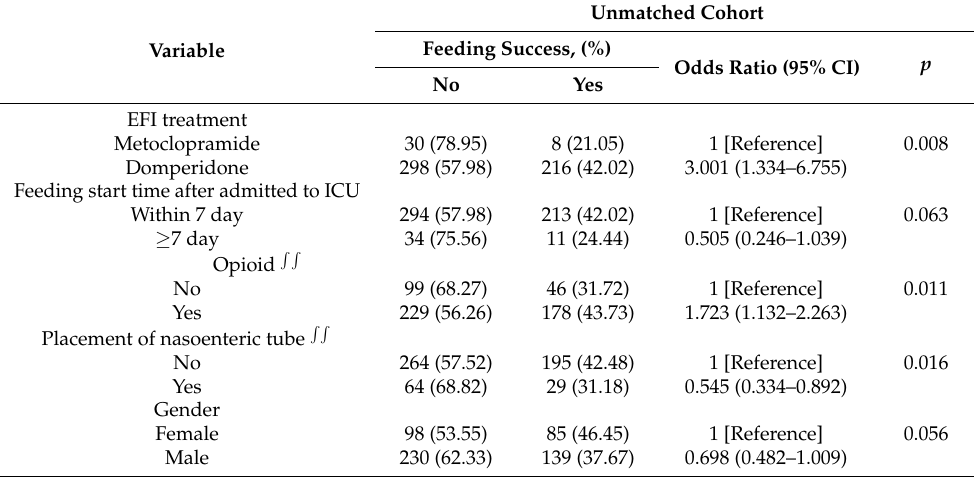
Table 3. Multivariate backward logistic regression model for primary outcome in unmatched cohorts.